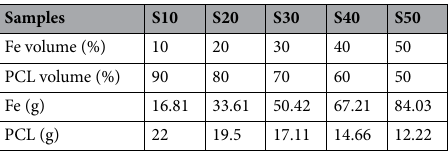
Table 1. Iron and PCL proportions in volume and weight for each